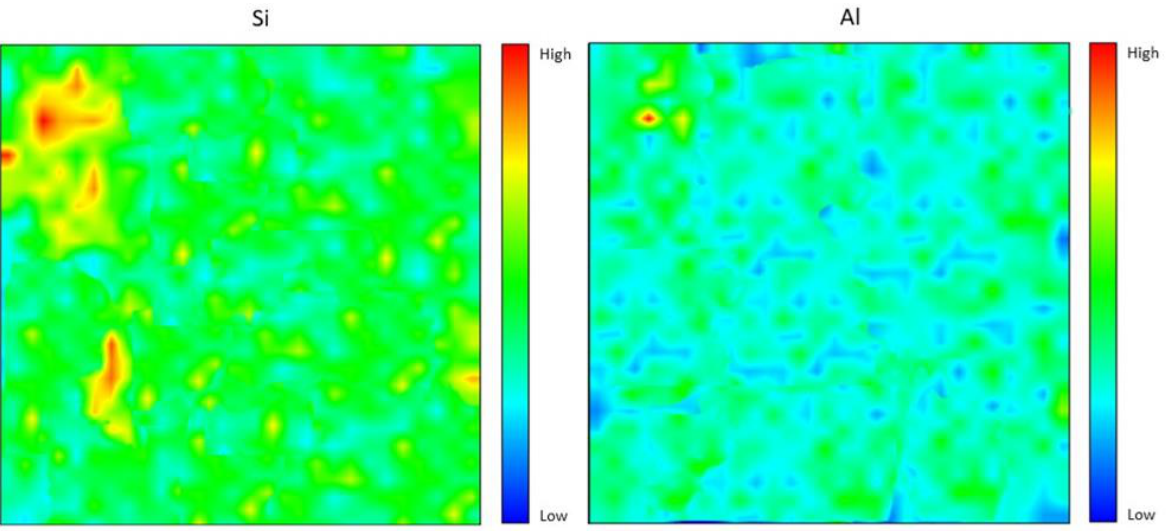
Figure 9. Si and Al elemental distribution for 8 M of NaOH fly ash/dolomite geopolymer.